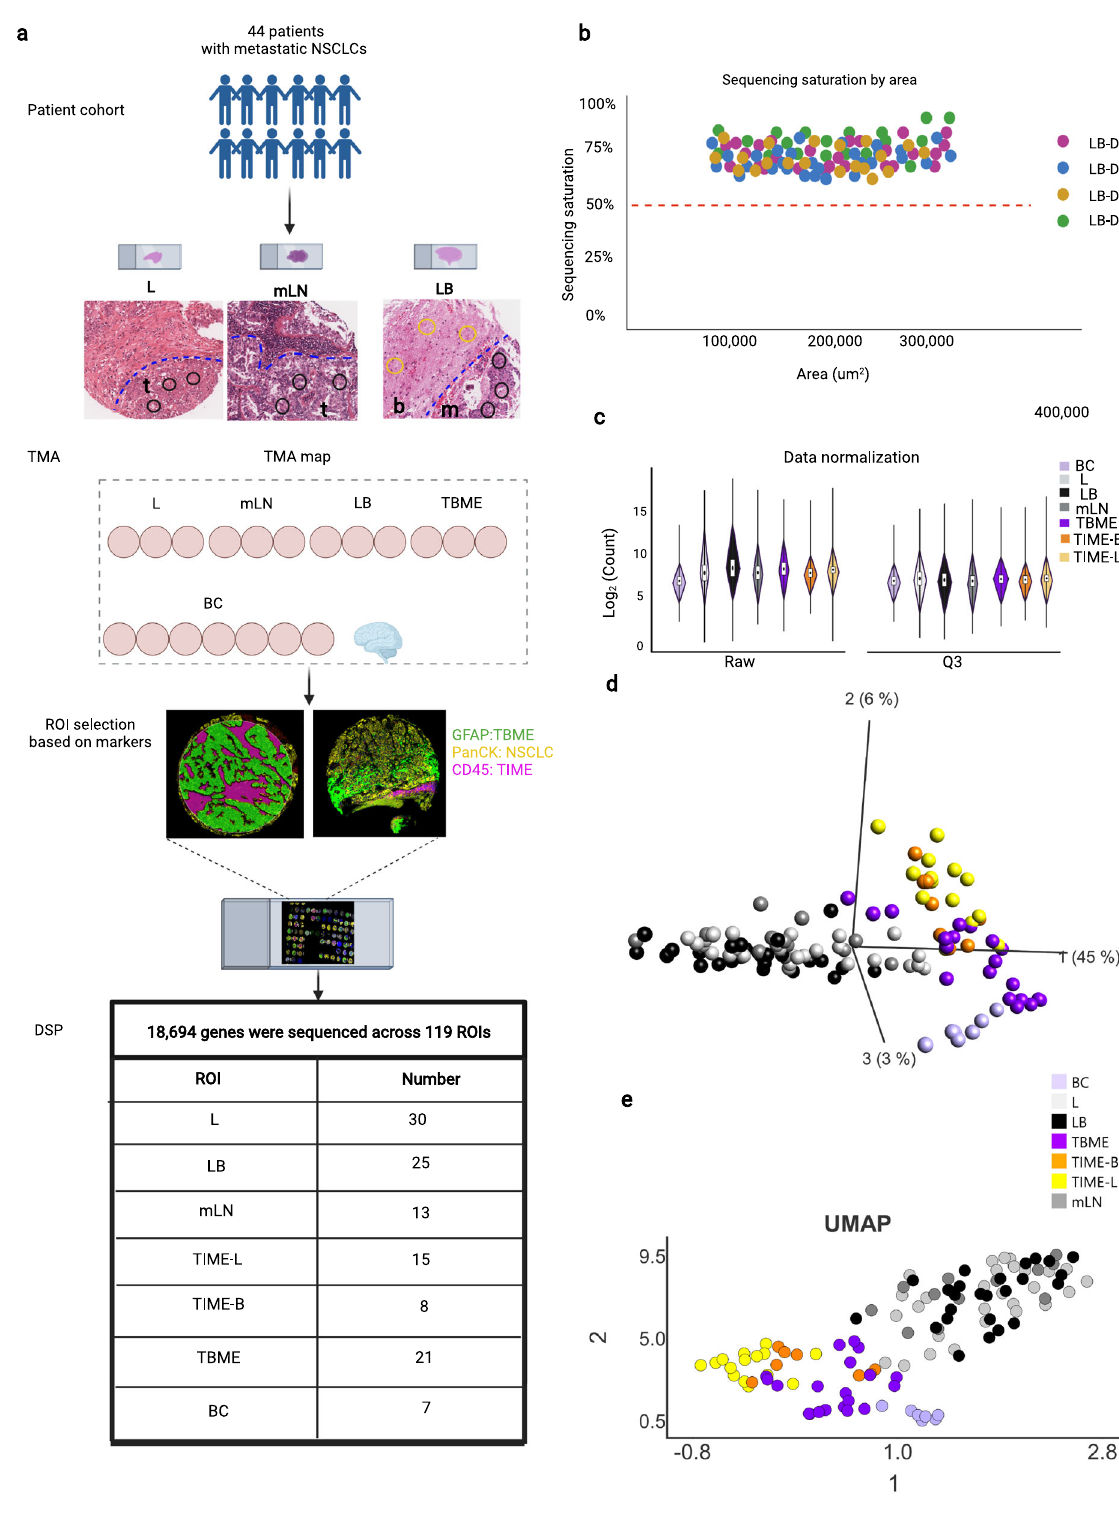
Fig. 1 | Digital spatial pro fi ling of primary NSCLC and metastasized tumor tissues.a Schematicofstudydesignandwork fl ow.NSCLCpatientswithmetastases to the brain ( n =44) were represented in four tissue microarray (TMA) blocks (LB-D1 to D4) for digital spatial pro fi ling (DSP) of the whole transcriptome (18,694 genes). Regions-of-interest (ROI) for DSP were annotated based on histology by a pathologist and immuno fl uorescence staining with the morphological markers PanCK (for epithelial cells), CD45 (for hematopoietic cells), and GFAP (for brain cells). A total of 119 ROIs (average 0.2mm 2 each) were analyzed. The fi gure was created with BioRender. The scale bar is 100 μ m. b RNA-sequencing saturation